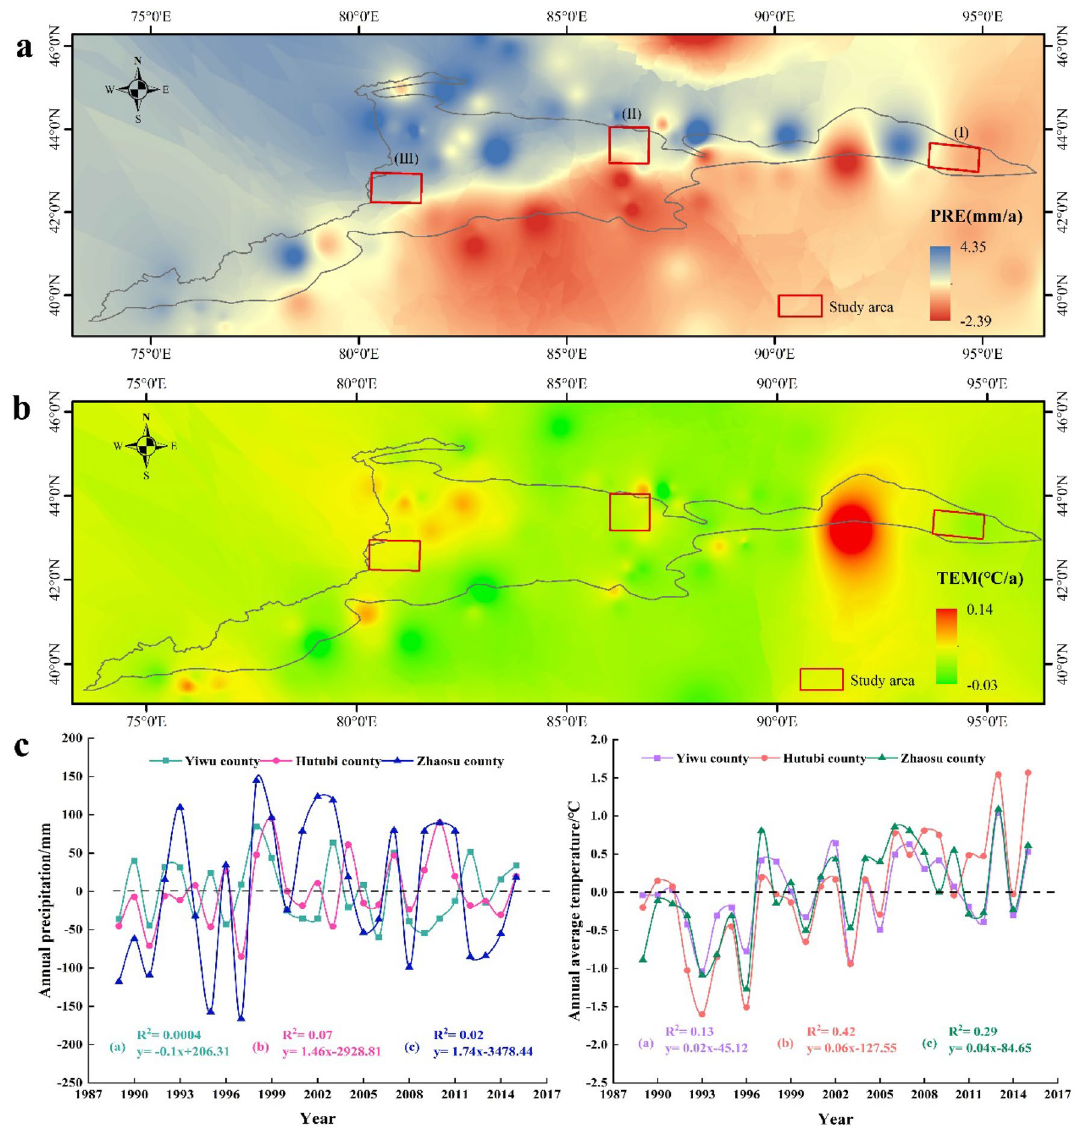
Figure 2. Spatial variation of temperature and precipitation [( a ) indicated spatial variation of precipitation in Tianshan Mountains and surrounding areas; and ( b ) indicated spatial variation of temperature in Tianshan Mountains and surrounding areas]. ( c ) Indicated the changing trend of temperature and precipitation in the study area during 1989–2015. The Mann Kendall (MK) trend test was used to identify the climate change (i.e., temperature and precipitation) trend of the Tianshan Mountains during